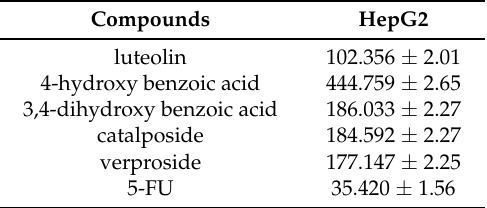
Table 4. Anti-hepatocarcinoma activity of target compounds (IC 50 , µ